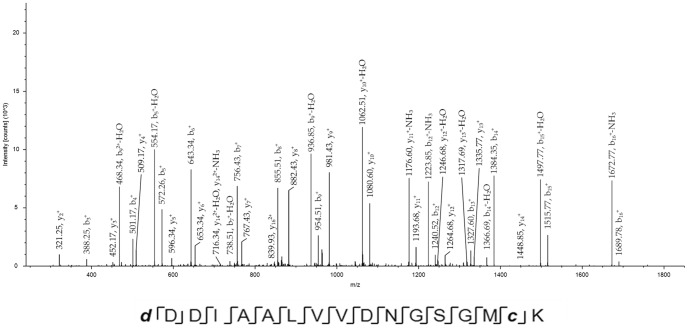
β- and γ-actin are N-terminally acetylated. Mass spectrum of the N-terminal peptide of β-actin.The protonated molecular ion (MH+) of the identified peptide has a mass of 1835.8 Da and is modified by removal of Met1 (m = 1722.9 Da), acetylation of Asp1 (indicated as d, Δm = +42 Da) and due to sample processing by an artificial propionamidation of cysteine (indicated as c, Δm = +71 Da). Similar results were obtained with γ-actin (spectrum not shown).